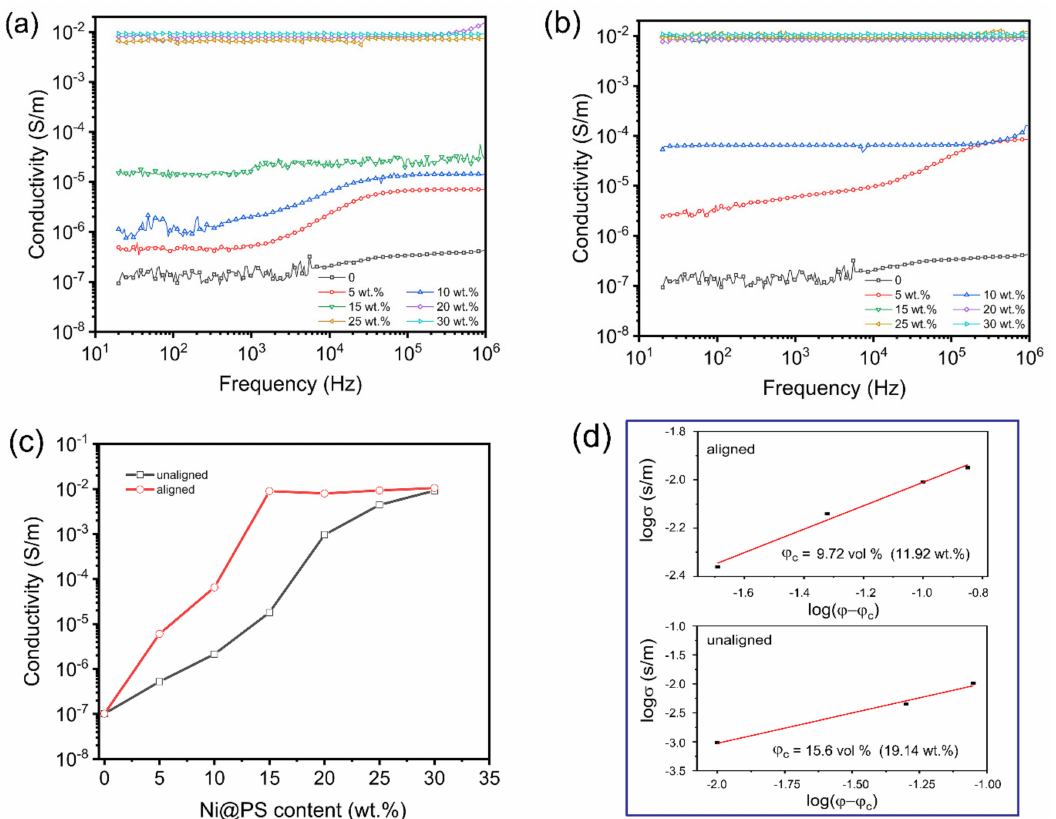
Figure 10. Dependence of electrical conductivity of Ni@PS/EP composites on the frequency at room temperature: ( a )without application of electric field, ( b ) with 300 V/mm of electric field strength. ( c ) Electrical conductivity of Ni@PS/EP composites with different Ni@PS content at 1000 Hz. ( d ) log σ plotted against log ( ϕ – ϕ c ) for the Ni@PS/EP composites with unaligned and aligned Ni@PS,